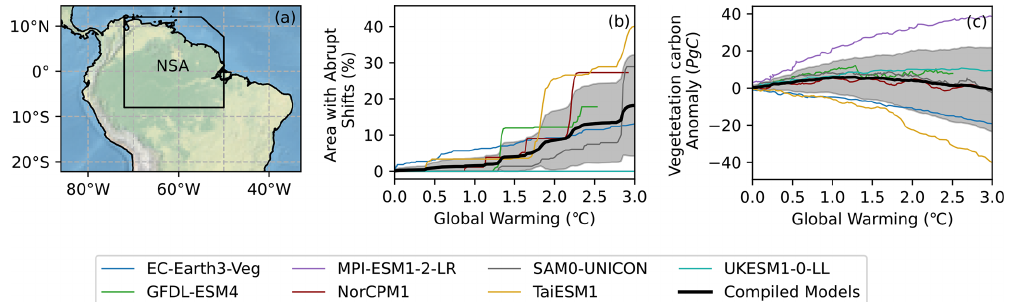
Figure 2. Plots showing the evolution of abrupt dieback shifts and vegetation carbon with global warming. (a) IPCC AR6-defined northern South America (NSA) region of the Amazon. (b) Plot showing the evolution of the percentage of the NSA region that has experienced an abrupt shift with increasing global warming. (c) Plot showing how the vegetation carbon anomaly relative to the mean of the first 10 years evolves with global warming. The plumes in (b) and (c) indicate the error in the averaged line (black) of the CMIP6 models.